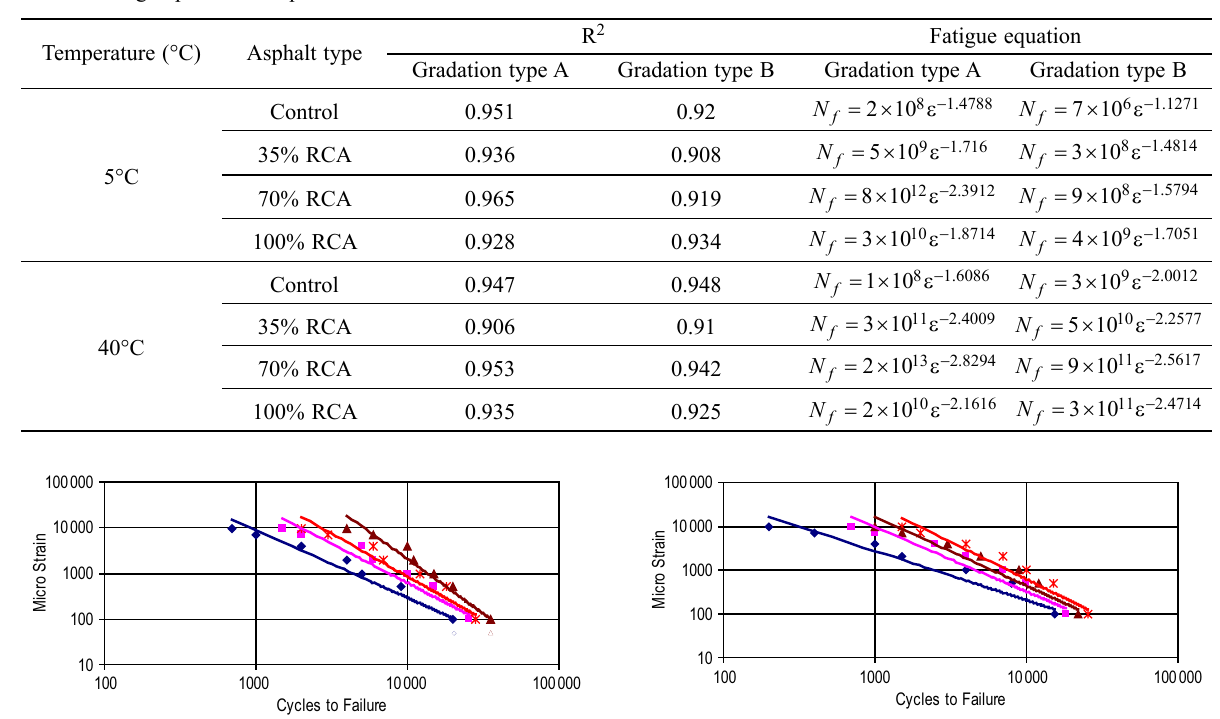
Table 5. Fatigue prediction equations of mixtures